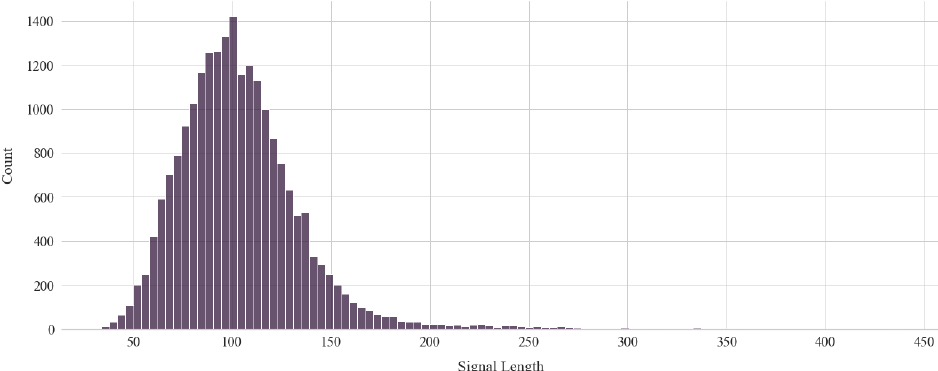
Figure 2. Histogram of the length of all samples from smart-band